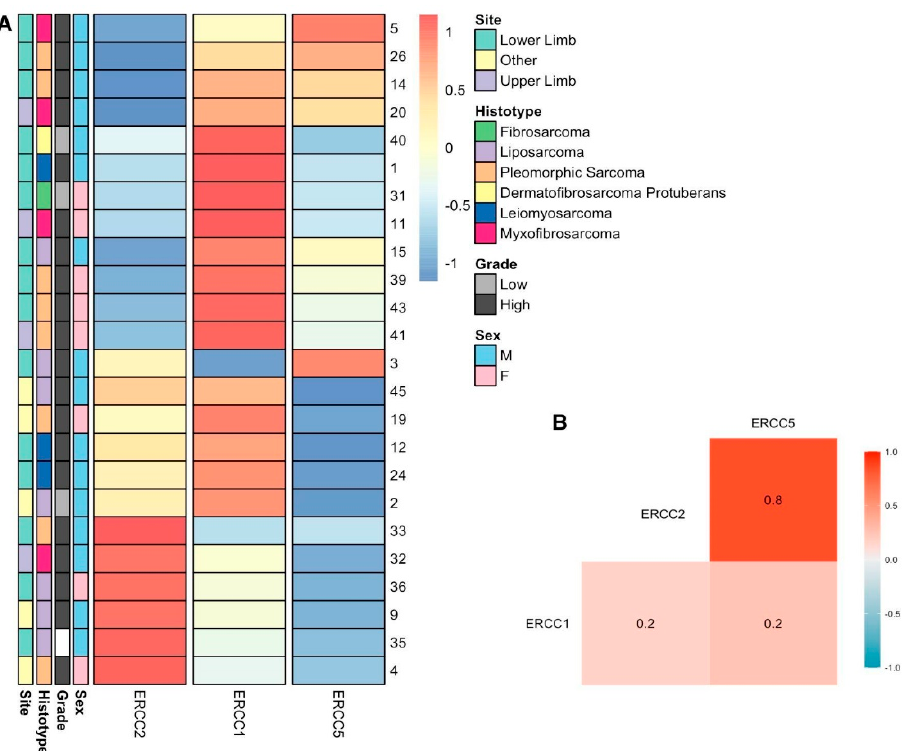
Figure 6. ( A ) Relative expression clusters of ERCC1, ERCC2 and ERCC5 per patient. The rows represent each sample and its respective ID, sex, histotype and grade. The columns represent the relative expression of ERCC1, ERCC2 and ERCC5 as log Fold Change values. ( B ) Correlation matrix of ERCC1, ERCC2 and ERCC5 relative gene expression with Pearson’s correlation similarity. M, male; F, female.